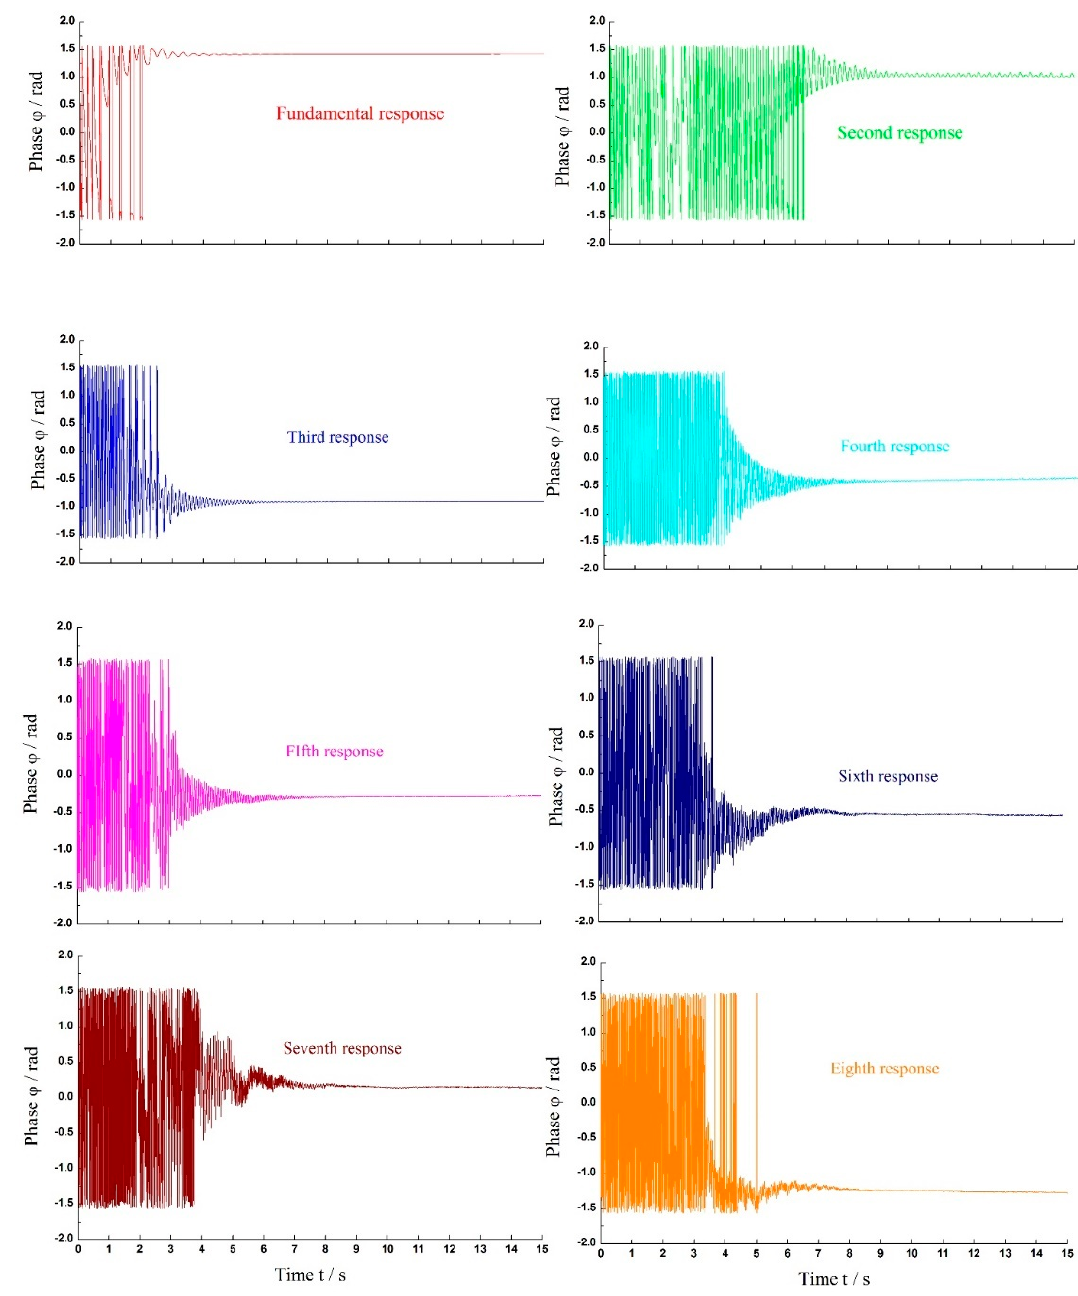
Figure 17. The estimation phases of experiment result.